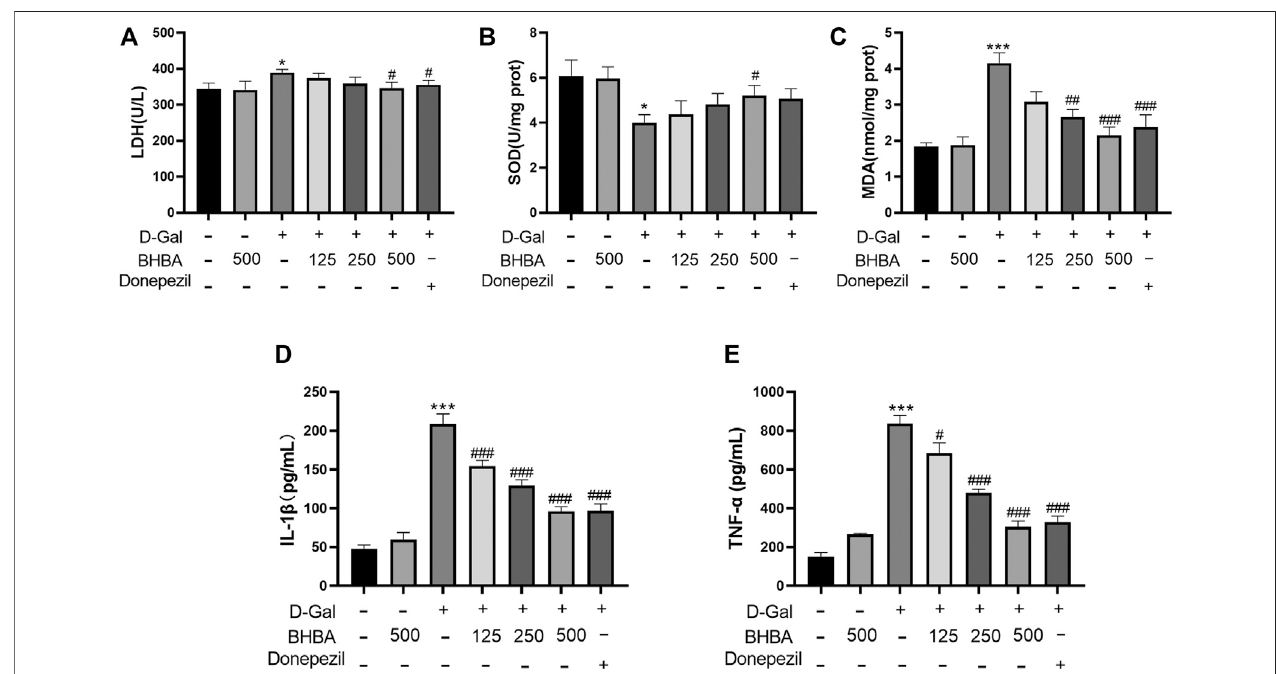
FIGURE3| EffectsofBHBAonhippocampaloxidativestressandin fl ammationinD-gal-inducedmice. (A) ActivityofLDH. (B) ActivityofSOD. (C) ContentofMDA. (D) Content of IL-1 β . (E) Content of TNF- α . D-gal: 180 mg/kg; BHBA: 125, 250, and 500 mg/kg, respectively; donepezil: 3 mg/kg, n (cid:1) 7 – 8. Compared with the control group, * p < 0.05, *** p < 0.001; Compared with the D-gal group, # p < 0.05, ## p < 0.01, ### p < 0.001.